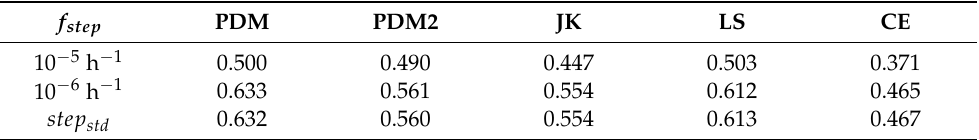
Table 6. The proportion of asteroids having a successful periodic recovery for different period finding algorithms using different frequency search grids.